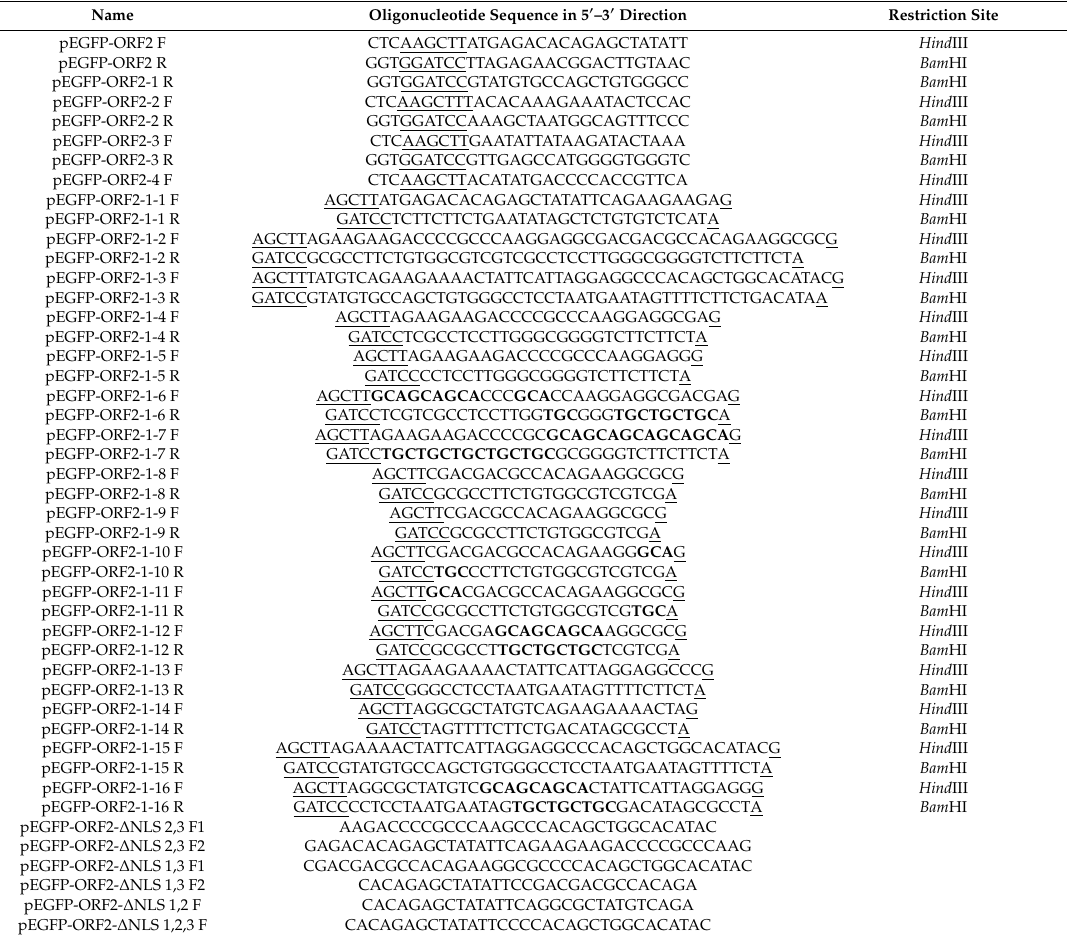
Table 1. Oligonucleotides. Oligonucleotide Sequence in 5 (cid:48) –3 (cid:48)